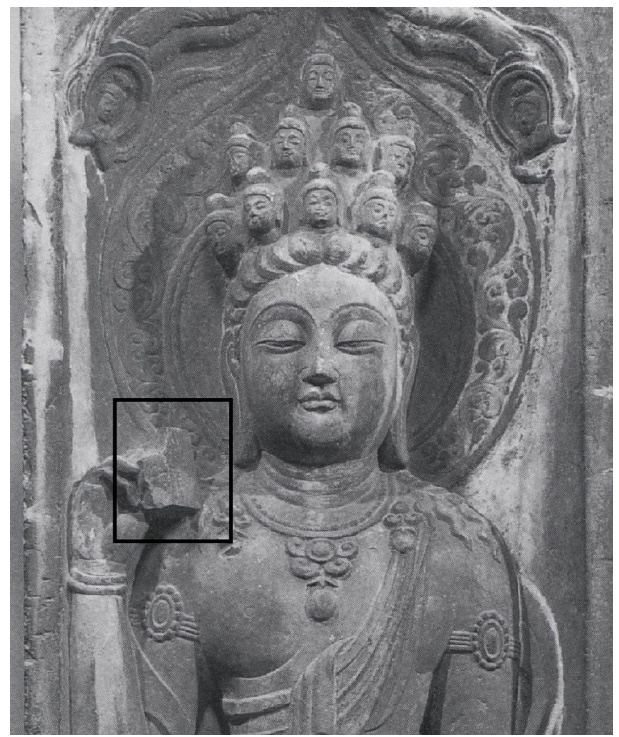
Figure 19. ‘Miezui (repentance)’ seal in the right hand of the eleven-headed Avalokite ś vara, Tang Dynasty, 703–704, Nara National Museum [Source: (Matsubara 1995, plate 655)].